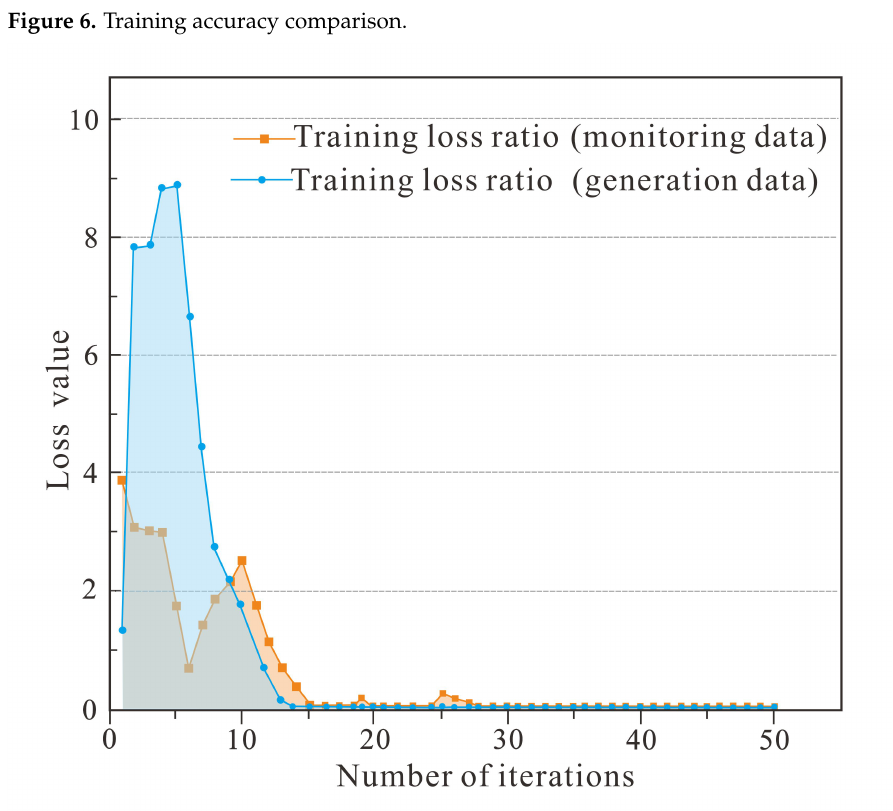
Figure 7. Training loss value